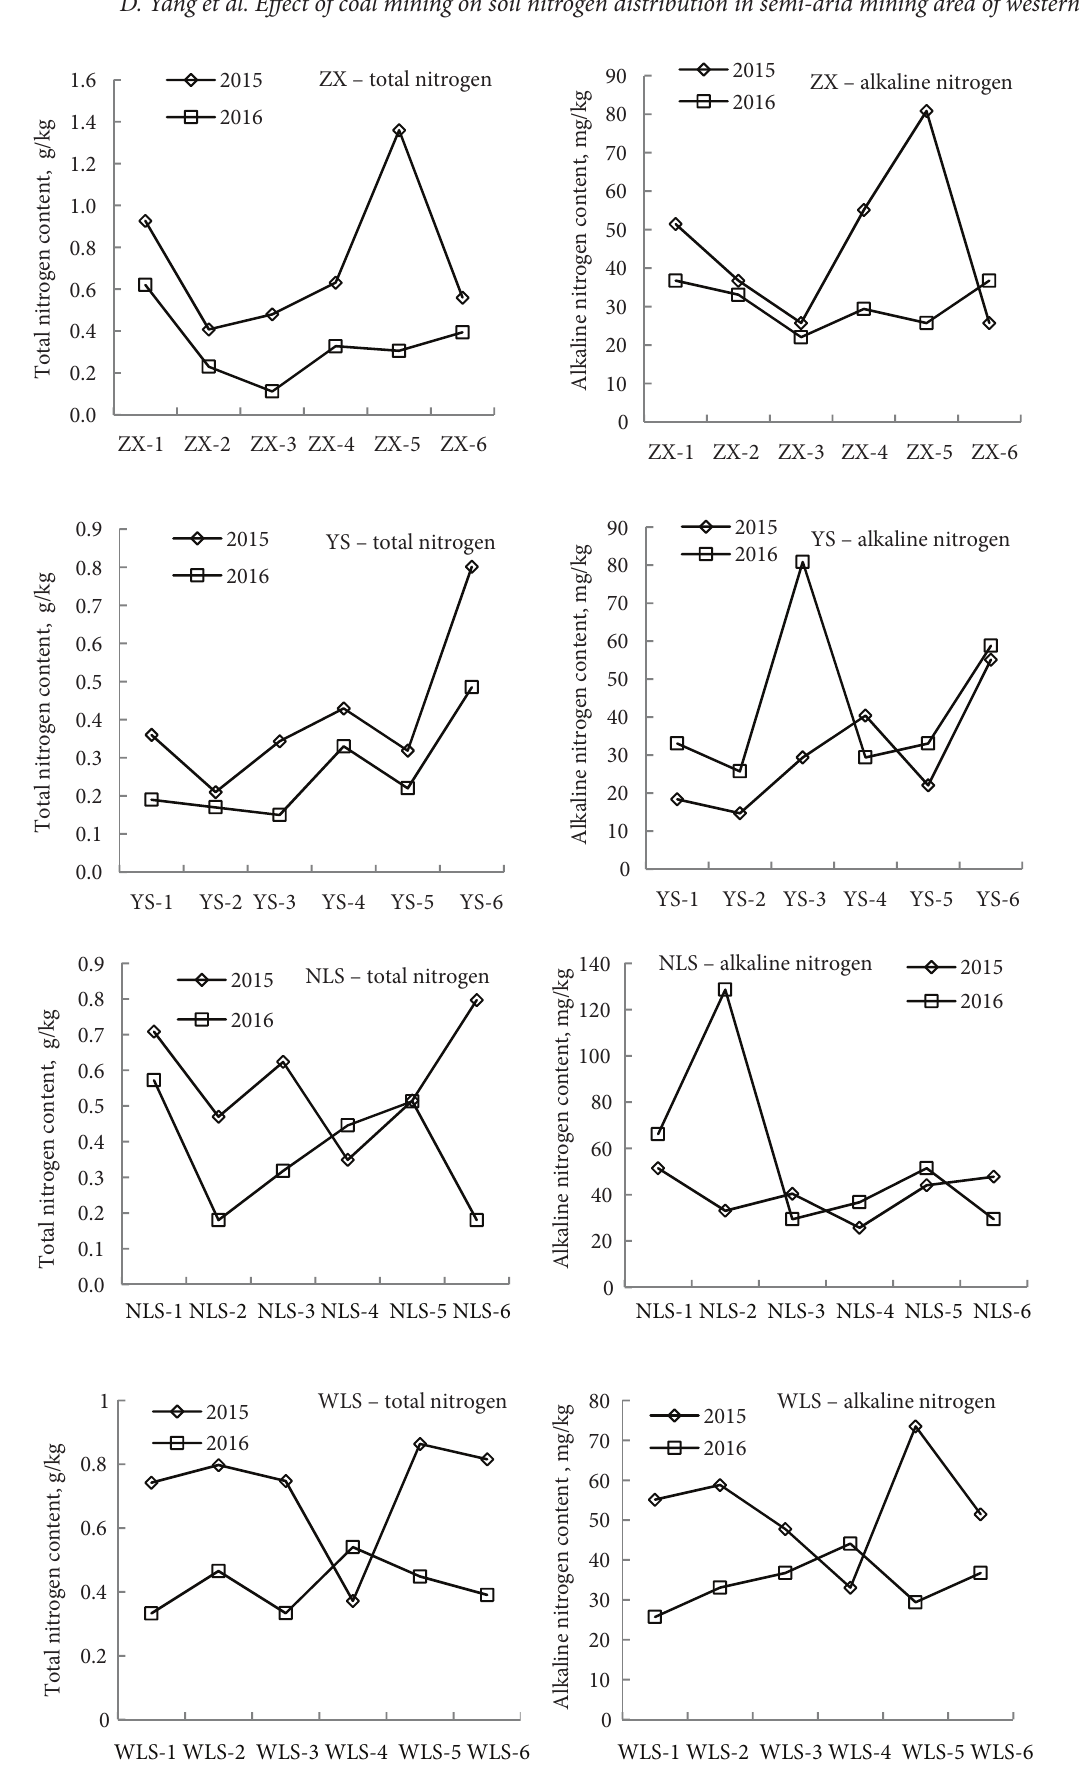
Figure 4 .The comparisons of soil nitrogen content in different regions of the loess region between 2015 and